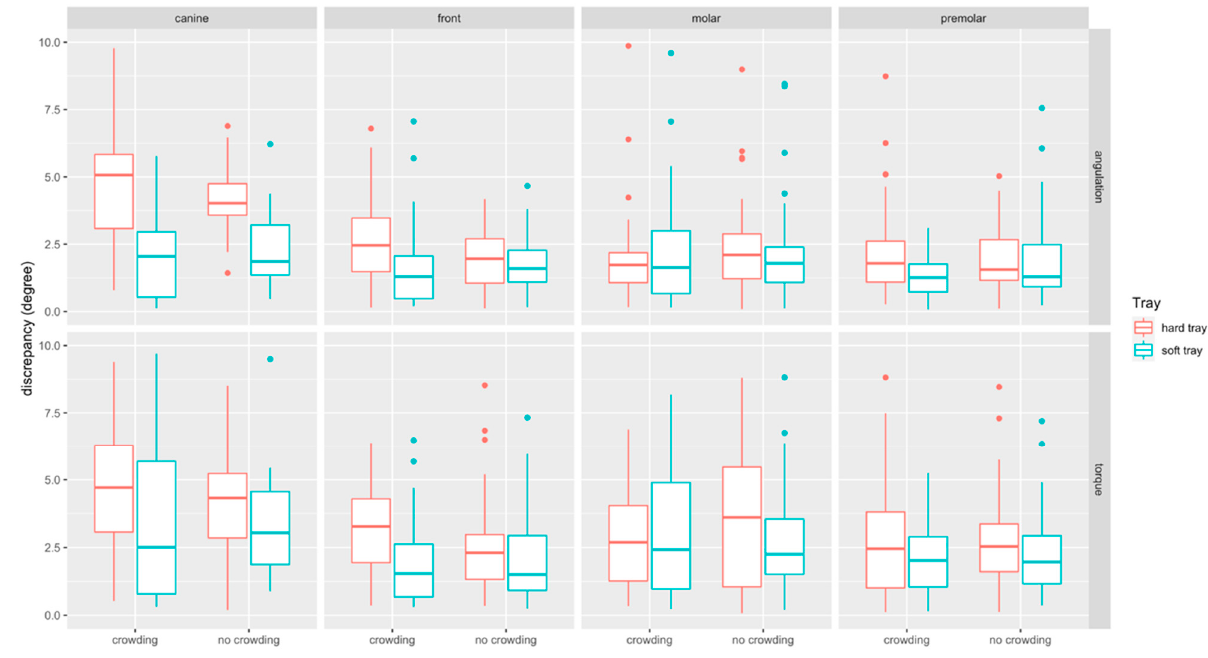
Figure 8. Boxplots detailing the accuracy of bracket transfer for angular measurements. Results are summarized for the canines, front teeth, molars, and premolars and split up into hard/soft trays and no crowding/crowding.